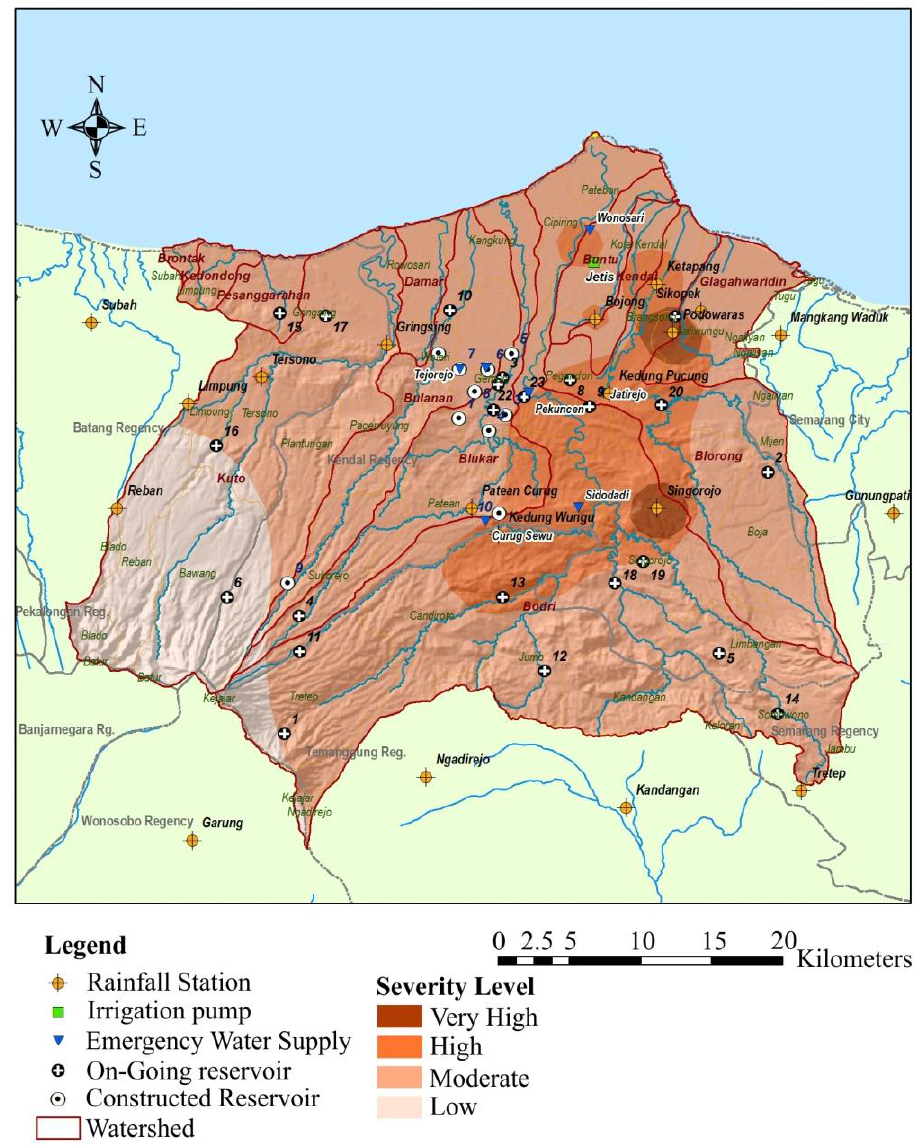
Figure 10. Overlay of small reservoir locations and drought severity map.